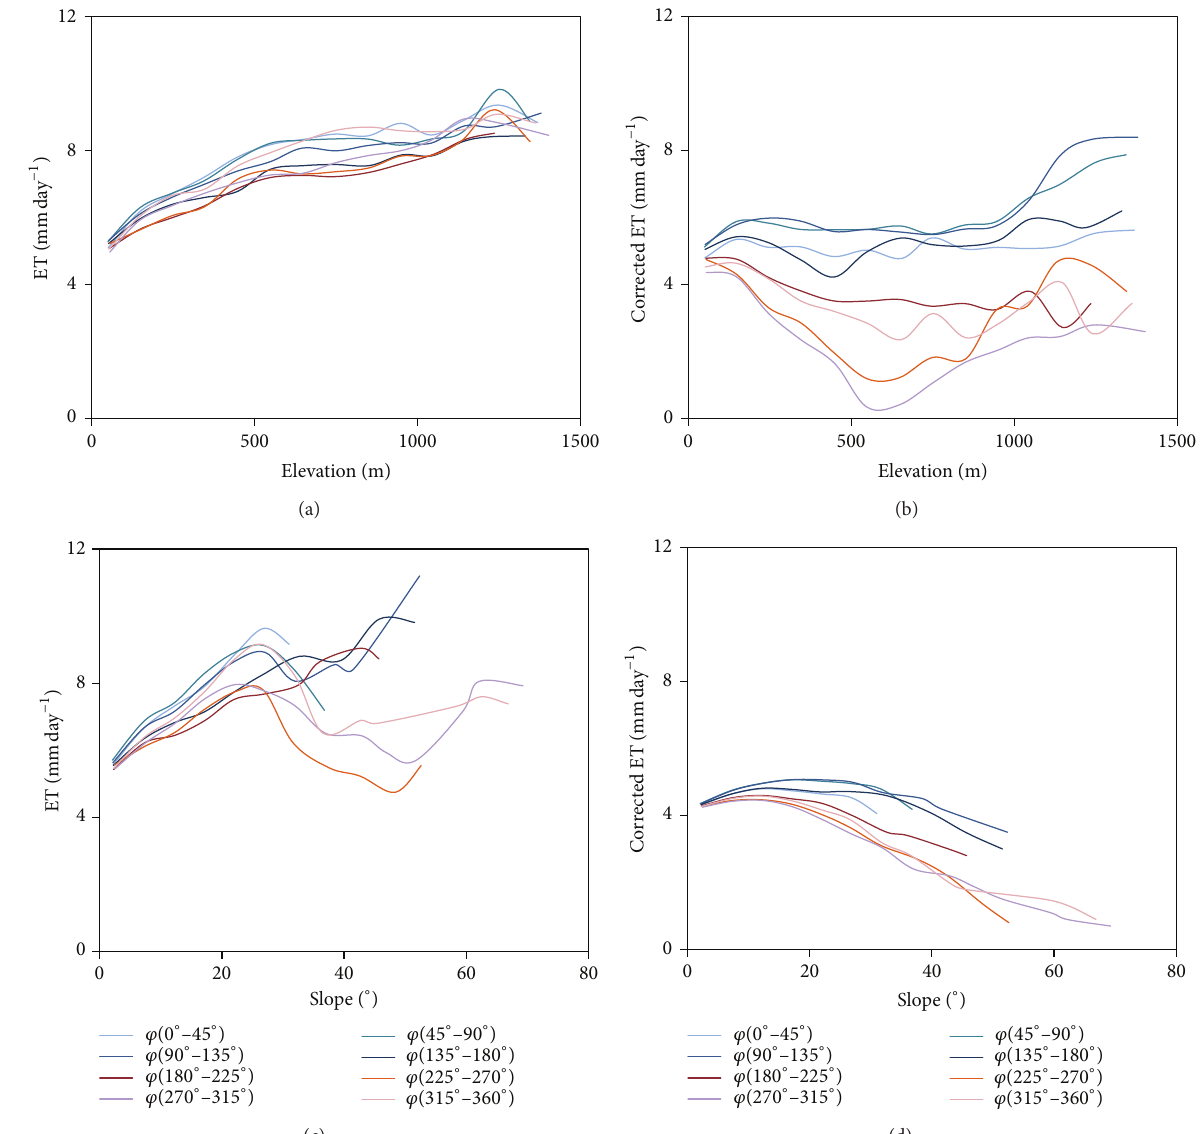
Figure5:TheETresponsetoelevationsandslopesfordifferentaspectanglesofterrain (𝜑) overtheselectedTaihuBasinarea.(a)Theelevation before the topographic correction, (b) elevation after the topographic correction, (c) slope before the topographic correction, and (d) slope after the topographic